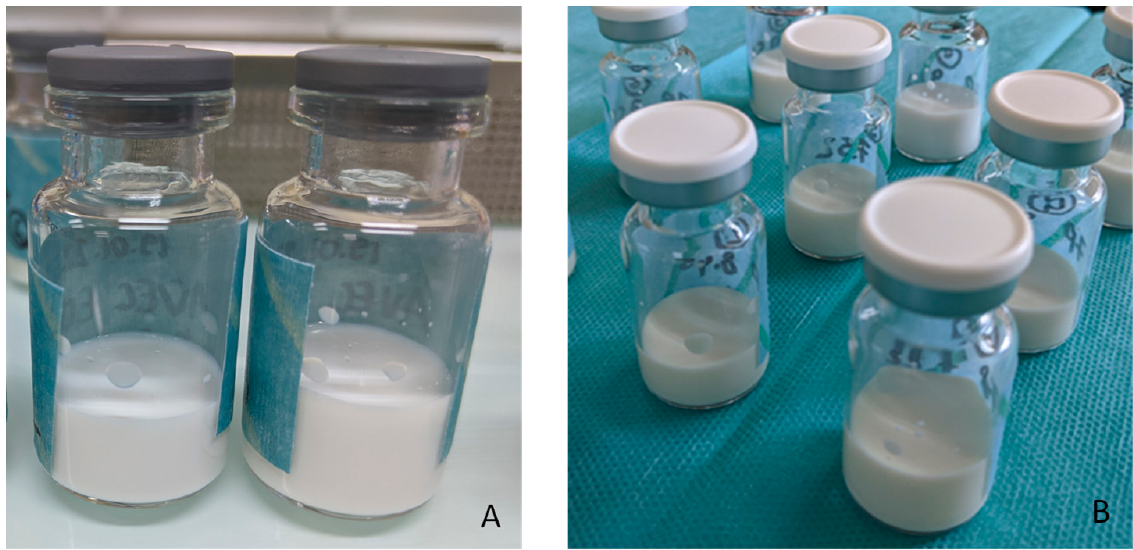
Figure 3. NE of propofol before ( A ) and after ( B ) heat sterilization (pH 9.5 adjusted prior to steri- lization).